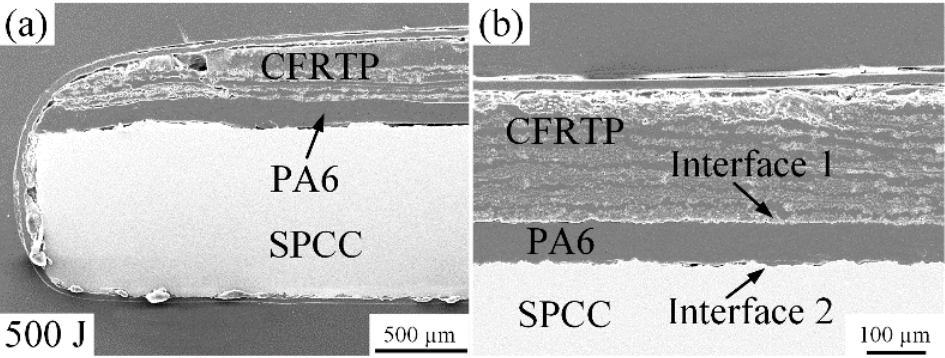
Figure 7. Microstructure of the joint cross-section at the 500 J energy: ( a ) the corner of the joint; ( b ) interface morphology.